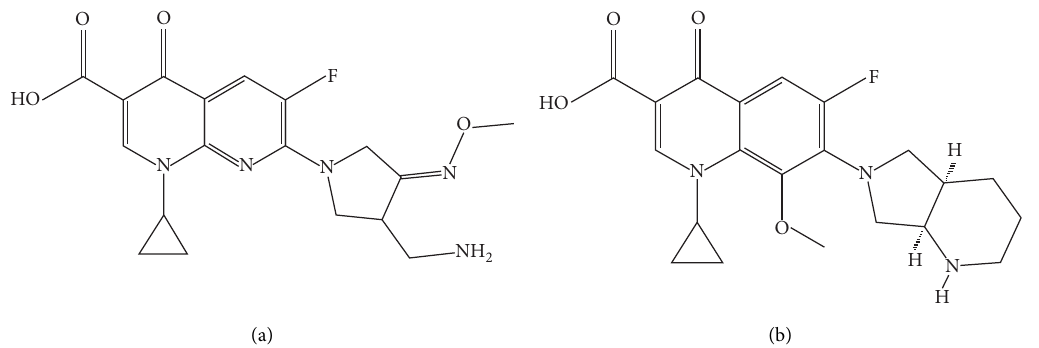
Figure 1: Structure of (a) gemifoxacin and (b) moxifoxacin (internal standard).